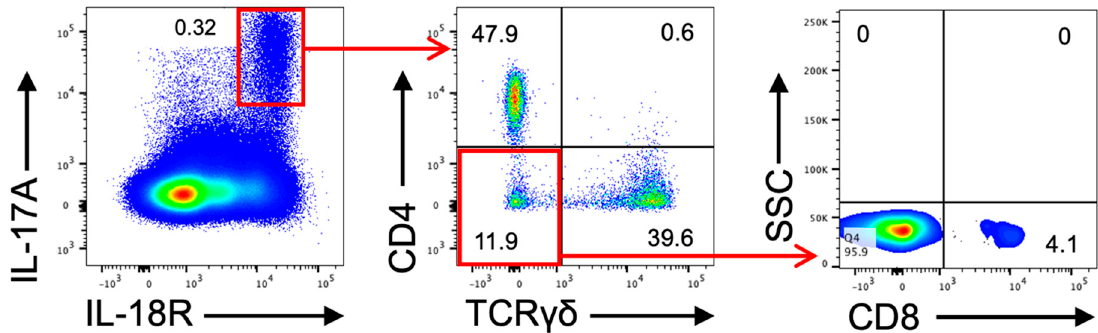
Figure 5. Identification of IL-17A-producing cell in KCASP1Tg mice. Cells from the cervical lymph nodes were isolated and analyzed via flow cytometry to identify IL-17-producing lymphocytes. The numbers indicate the percentage of cells in each gate. Note that IL-18R-positive CD4 T cells, gamma delta T cells, and CD8 T cells were found to be the major IL-17-producing cells in this order. (SSC, side